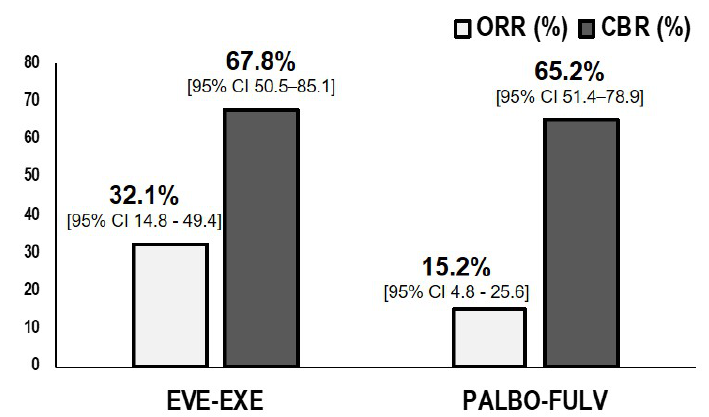
Figure 3. Objective response rate (ORR) according to RECIST 1.1 and clinical benefit rate (CBR). EVE: everolimus; EXE: exemestane; PALBO: palbociclib; FULV: fulvestrant; CI: confidence interval; p -value: